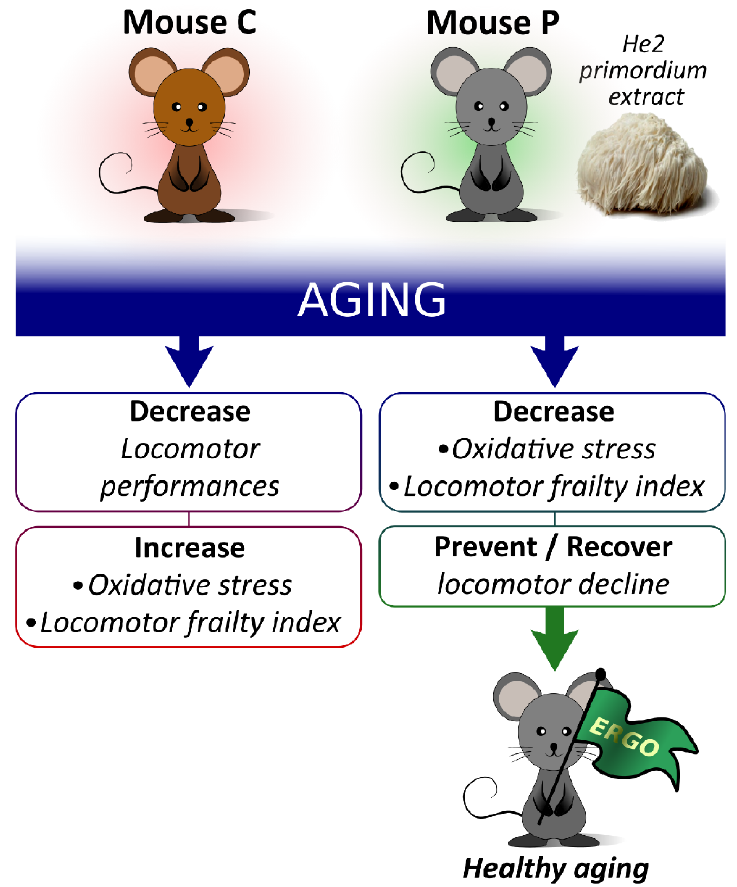
Figure 7. Pictorial illustration summarizing main results and take-home message.